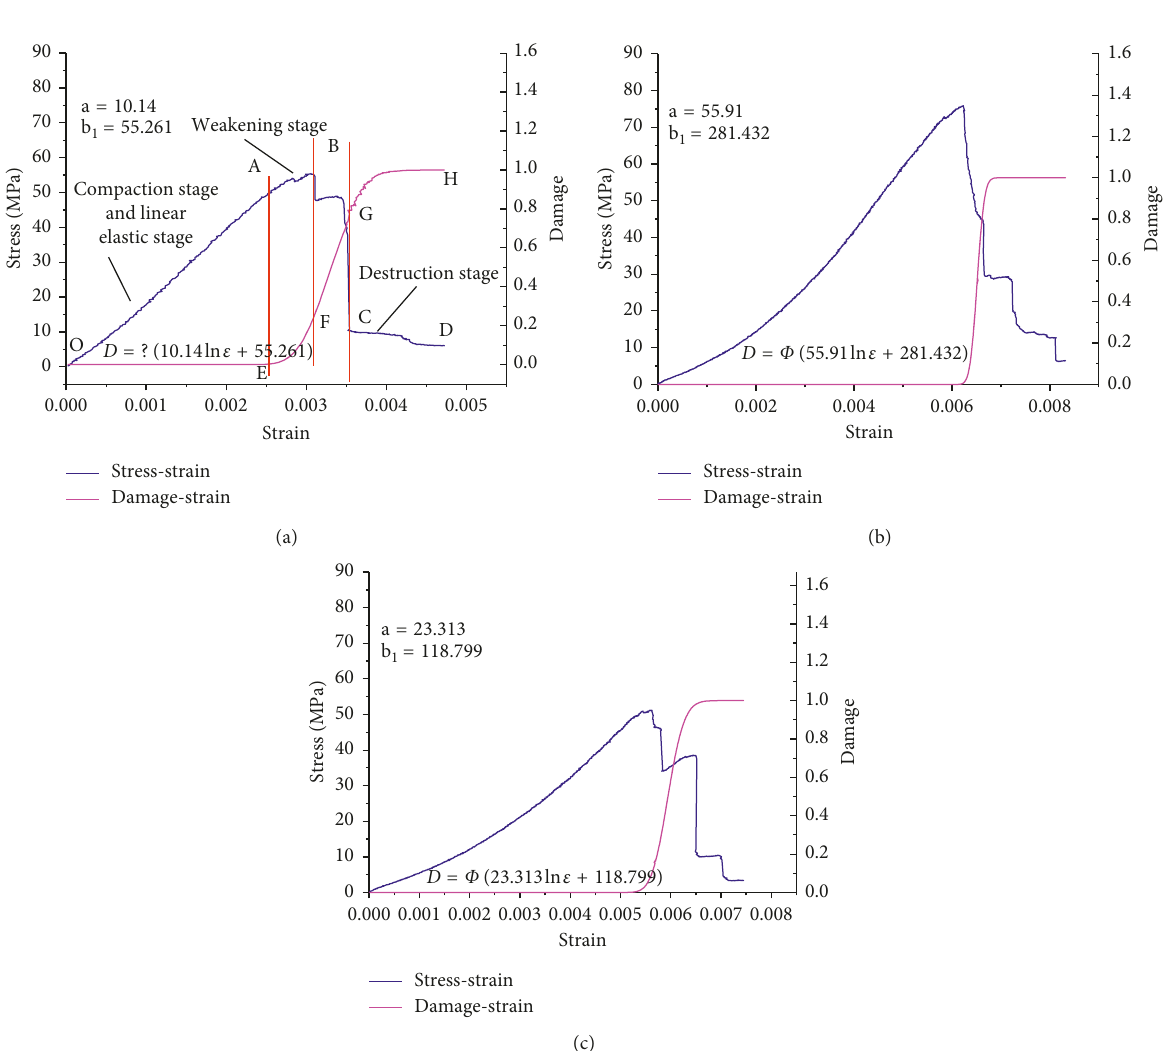
Figure 1: Specimen of sand